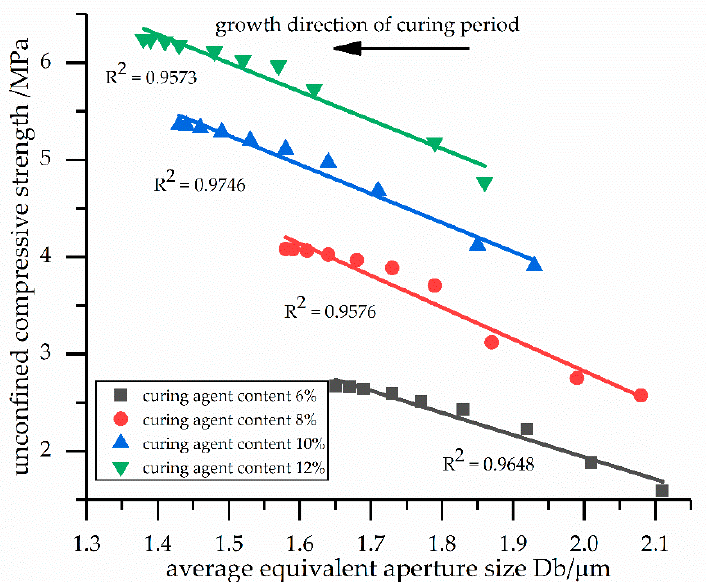
Figure 7. Relationship between the unconfined compressive strength and the average equivalent aperture size.